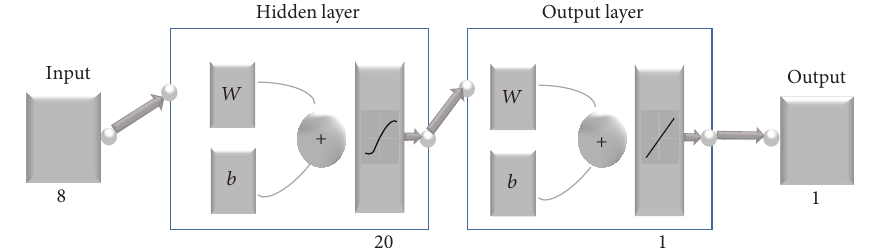
Figure 6: Neural Network feedforward 3-layer architecture.